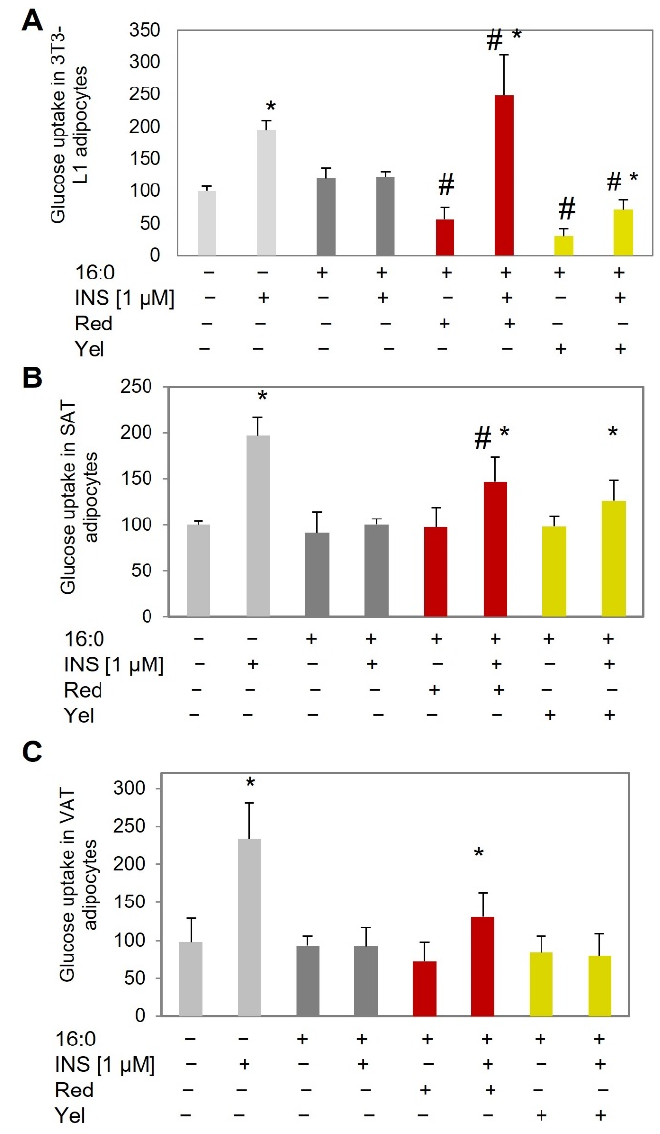
Figure 2. Glucose uptake test in control adipocytes and adipocytes with insulin resistance (induced using palmitic acid, 16:0) at baseline and after insulin stimulation (INS), and in IR adipocytes treated with red and yellow CM fruit extract at the concentration of 0.01 mg/mL in: ( A ) 3T3-L1 adipocytes, ( B ) SAT-derived human adipocytes, ( C ) VAT-derived human adipocytes. * p < 0.05 compared to the baseline (INS − ) of the appropriate group of cells, # p < 0.05 compared to IR cells of the appropriate group (INS − or INS+). Results have been presented as mean ± SD.